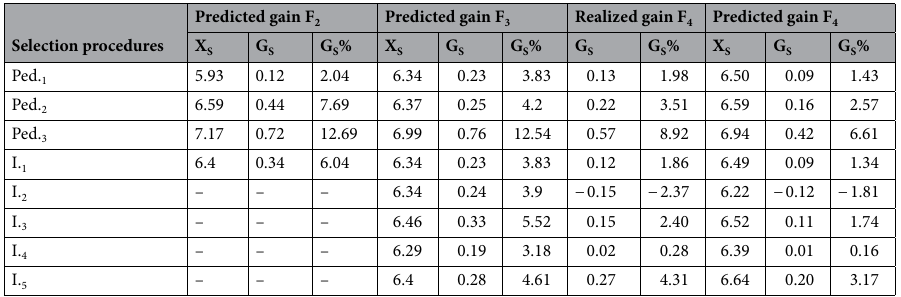
Figure 1 explains the density plots of the studied traits for the three generations using smoothed kernel density function of the values. Each density plot shows both the distribution of the values and their probability. The area under the curve represents the distribution of the values of each trait, while the values on the Y-axis represent the probability of these values. The X-axis value that corresponds to the peak is the average of the feature. As shown from the figure, a higher concentration of each trait’s values was demonstrated by the peaks of each density plot, which means higher probability. In comparison, a lower concentration of the values of each trait was demonstrated by the tails of each density plot, which means lower probability. It is observed that the corresponding value to the peak of LI for F2 is differ- ent from F3 and F4, where the means of LI for F3 and F4 were higher than the mean of F2. The same trend was observed for SI, while the reverse was the case for SN. The density plots results show that the selection from F2 improved LI and SI means only and decreased the variation of all the studied traits. Figure 2 shows the stacked histogram for discriminant function values based on LD1. It’s evident that no overlaps were detected between F2 and F3, and F4. However, an overlap was observed between F3 and F4. These results demonstrated that selection among F2 plants has led to an improvement in the generation F3; however, selection among F3 plants has not led to an improvement in the generation F4. Figure 3 shows the biplot based on LD1 and LD2. It is clear that F2 was separated very clearly while an overlap was observed between F3 and F4. Based on arrows, LI explained more for F3 and F4 from F2, while SI explained more for F2 from F3 and F4 Table 7. On the other hand, BW could not explain among the three generations. At the same time, LY, BN, SN, and LP have no specific trend and can not be used to describe the variation or separate among the three generations. Path analysis. Path analysis 34 was performed using the R software version 4.1.0, 2021 using the function (sem), which stans for structural equation modeling, in the (lavaan) package. Then path diagram was drawn using the process (semPaths) in the same package . The results of path analysis are shown on the path diagrams in Figs. 4, 5, and 6. All the path diagrams included the effects of lint index (LI) and seed index (SI) on lint % (LP), boll number/plant (BN) and seed number/boll (SN) on boll weight (BW), lint % (LP) and boll weight (BW) on lint yield/plant (LY) for the three generations. Three types of arrows characterize the path diagram. The first type is single-headed arrows (paths) used to define the causal relationships, where the trait at the tail of the needle affects the attribute at the head. The second type is double-headed arrows connecting two characteristics that define their covariance. The third type is a double-headed arrow pointing to the same trait, representing the variance of that trait. It was observed that LP was strongly affected by LI and SI, where the R 2 values were 0.990, 0.834, and 0.980 for F2, F3, and F4, respectively. Also, BW was strongly affected by LI, SI, and SN, where the R 2 values were 0.986, and 0.978 for F2 and F3, respectively. However, it was moderately affected in F4 (R 2 = 0.487). LY was directly and strongly influenced by LI, SI, BN, and SN, where R 2 values were 0.980, 0.992, and 0.942 for F2, F3, and F4, respectively. Each direct effect (standardized estimates) is shown in the middle of the arrow, and each indirect effect is shown in parenthesis beside the direct effect. The direct effect of BN on LY was more substantial than the direct effect of LP and BW in the three generations. The indirect effect of LI and SI through LP had the same trend in the three generations, where LI had a positive effect while SI had a negative effect. SN had no indirect effect on LY through BW, while LI and SI had a positive indirect effect on LY through BW in the three generations. The direct and indirect effects on LY were more significant in F4 than in F2 and F3. These more substantial effects that have been found in F4 may be due to the effect of selection, which led to a stronger relationship between Lint yield and its components and consequently stabilized the progeny of the generation.